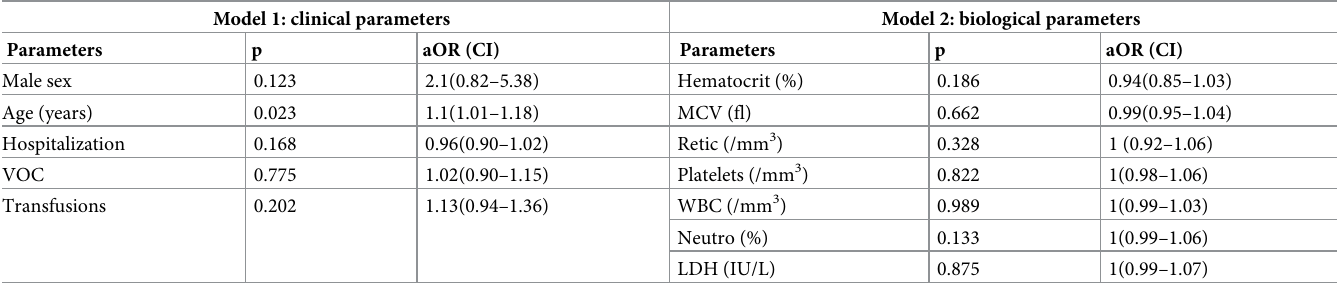
Table 6. Factors associated with hip